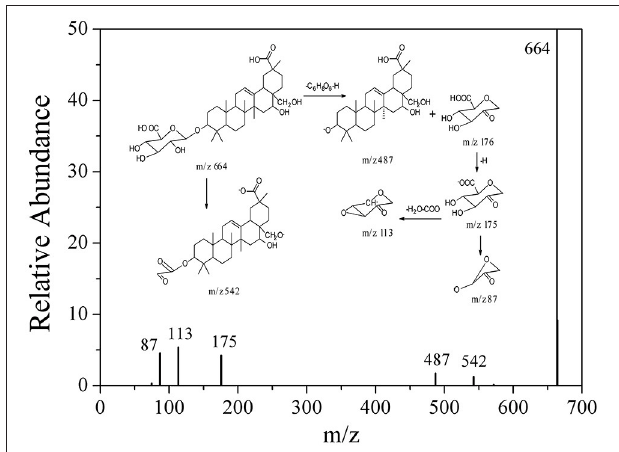
FIGURE 4 | The fragmentation pathways proposed according to the MS/MS spectra of compound